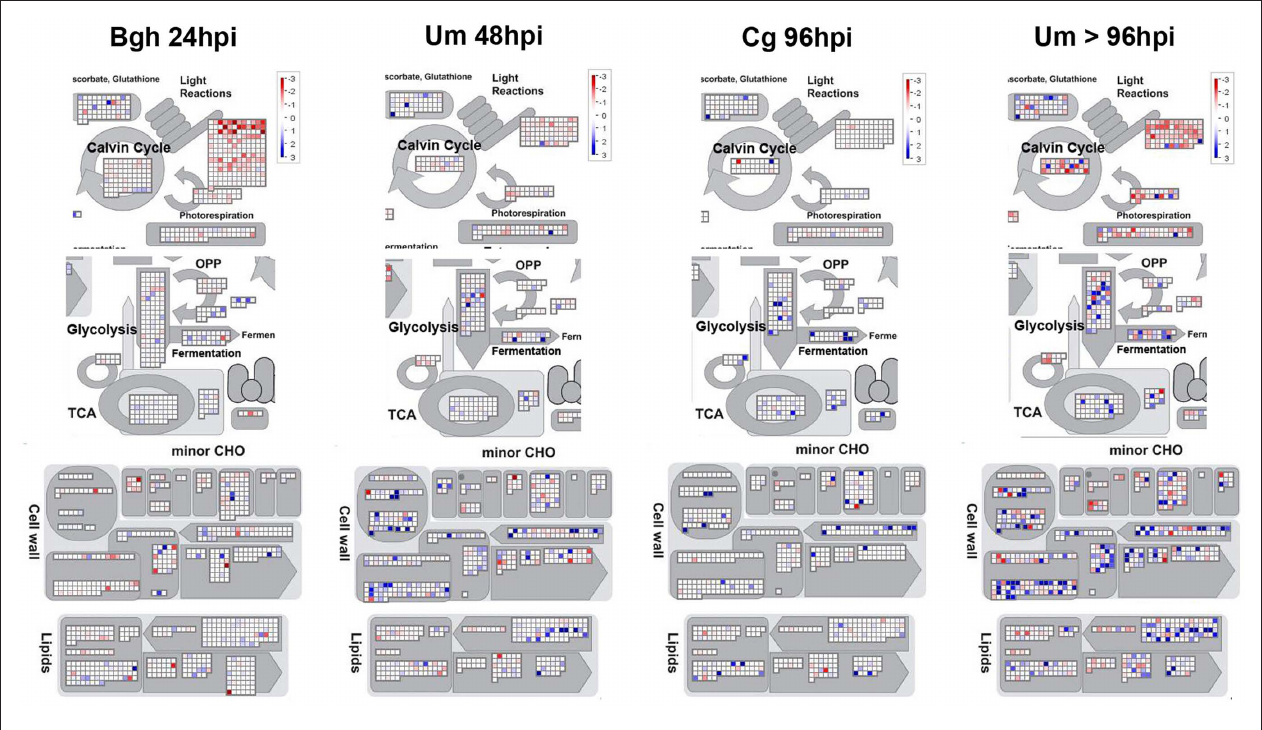
Figure 6 | visualization of specific transcriptional changes between biotrophy, necrotrophy, and tumors by MapMan analysis. Mean fold change of the transcripts in infected vs. mock treated samples was calculated based on all three replicate experiments per time point and log-scaled data were visualized using MapMan with all filters disabled. Data for established biotrophy ( Bgh 96hpi and Um 48hpi), necrotrophy ( Cg 96hpi), and Um tumors ( Um > 96hpi) are displayed from left to right. The scale bar represents fold